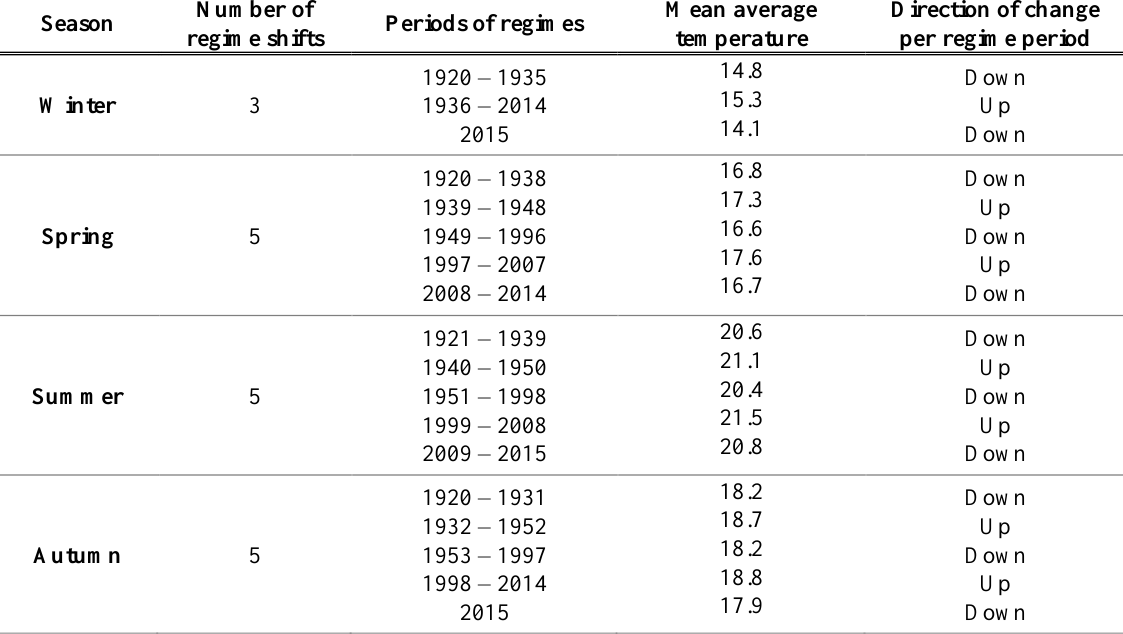
Table A4.1: Regime shifts according to seasons (tri-month average temperature) for Mossel